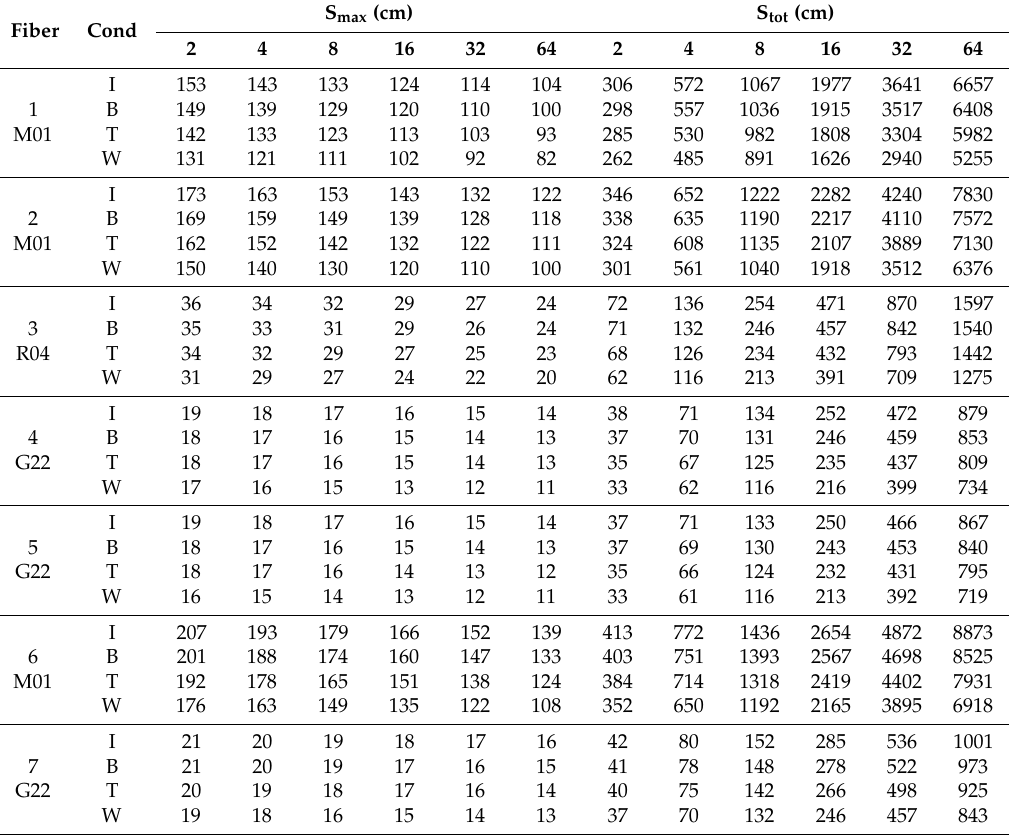
Table 3. Recap of the performance analysis of SLMux; the table reports the maximum sensing length per channel (S max ) and the total sensing length (S tot ), for each fiber type in theoretical, best, typical and worst operative conditions for N ranging from 2 to 64 channels. Conditions: I = ideal; B = best case; T = typical case; W = worst